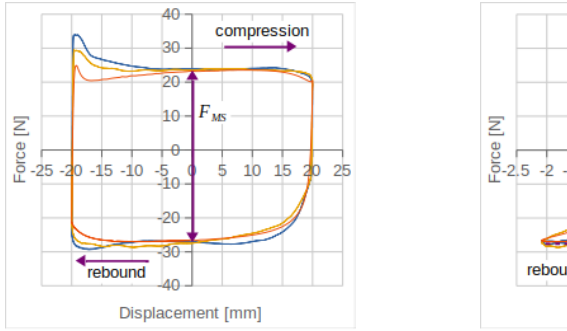
Figure 10. Comparison of the force displacement graphs ( left ) and the force speed graphs ( right ) of the full take-apart damper friction measurement, the superposition of the SFP measurements, and the super-positioned FEM friction simu- lation results; floating piston/tube friction contribution with regard to Equation (3). In summary, the friction simulation methodology introduced in part 1 of this study proves to be sufficiently robust against small variations in geometry and material data as they occur when replacing similar parts. The resulting quantitative deviation is within the acceptable measurement deviation and is therefore sufficiently small. The qualitative deviations mainly result from the uncertainties of SFP2 and the already discussed underestimation of tangential contact stiffness and tangential contact damping, which is caused by the imperfect separability of microscopic and macroscopic seal deformation due to friction. 4.2. Friction Model Parameter Transfer to Different Geometry This section demonstrates the transferability of the friction model parameters to a target geometry that is different from the source geometry originally used for the parameter estimation. Since all friction model parameters describe the microscopic properties of the friction contact of the source geometry, these properties must be similar between the source geometry and the target geometry. For this test, the reference damper’s rod guide assembly/rod friction point is exchanged with a rod guide